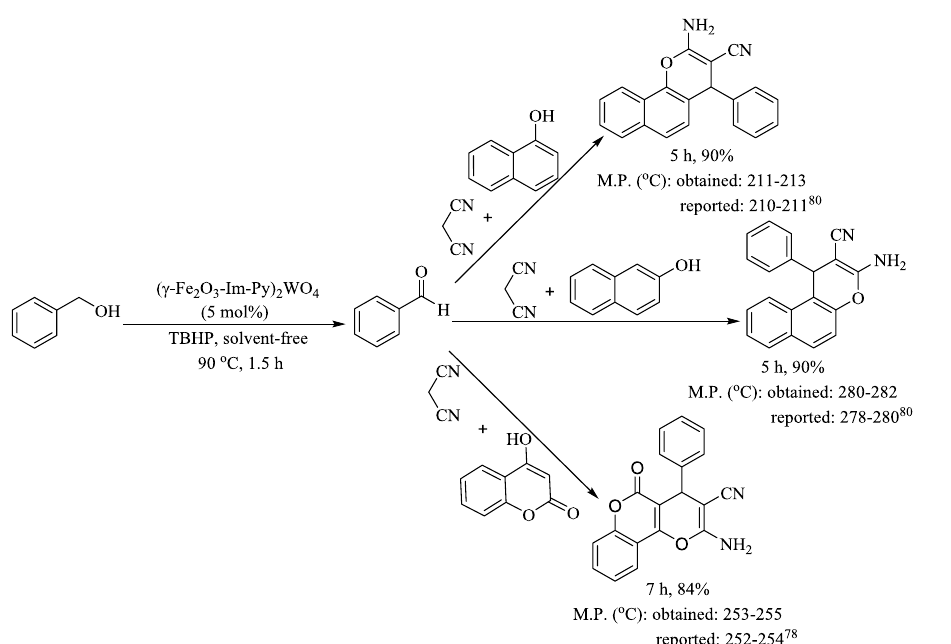
Figure 11. Multicomponent TOP of benzyl alcohol, malononitrile and α-naphthol/β-naphthol/4- hydrxycoumarin catalyzed by (γ-Fe 2 O 3 -Im-Py) 2 WO 4